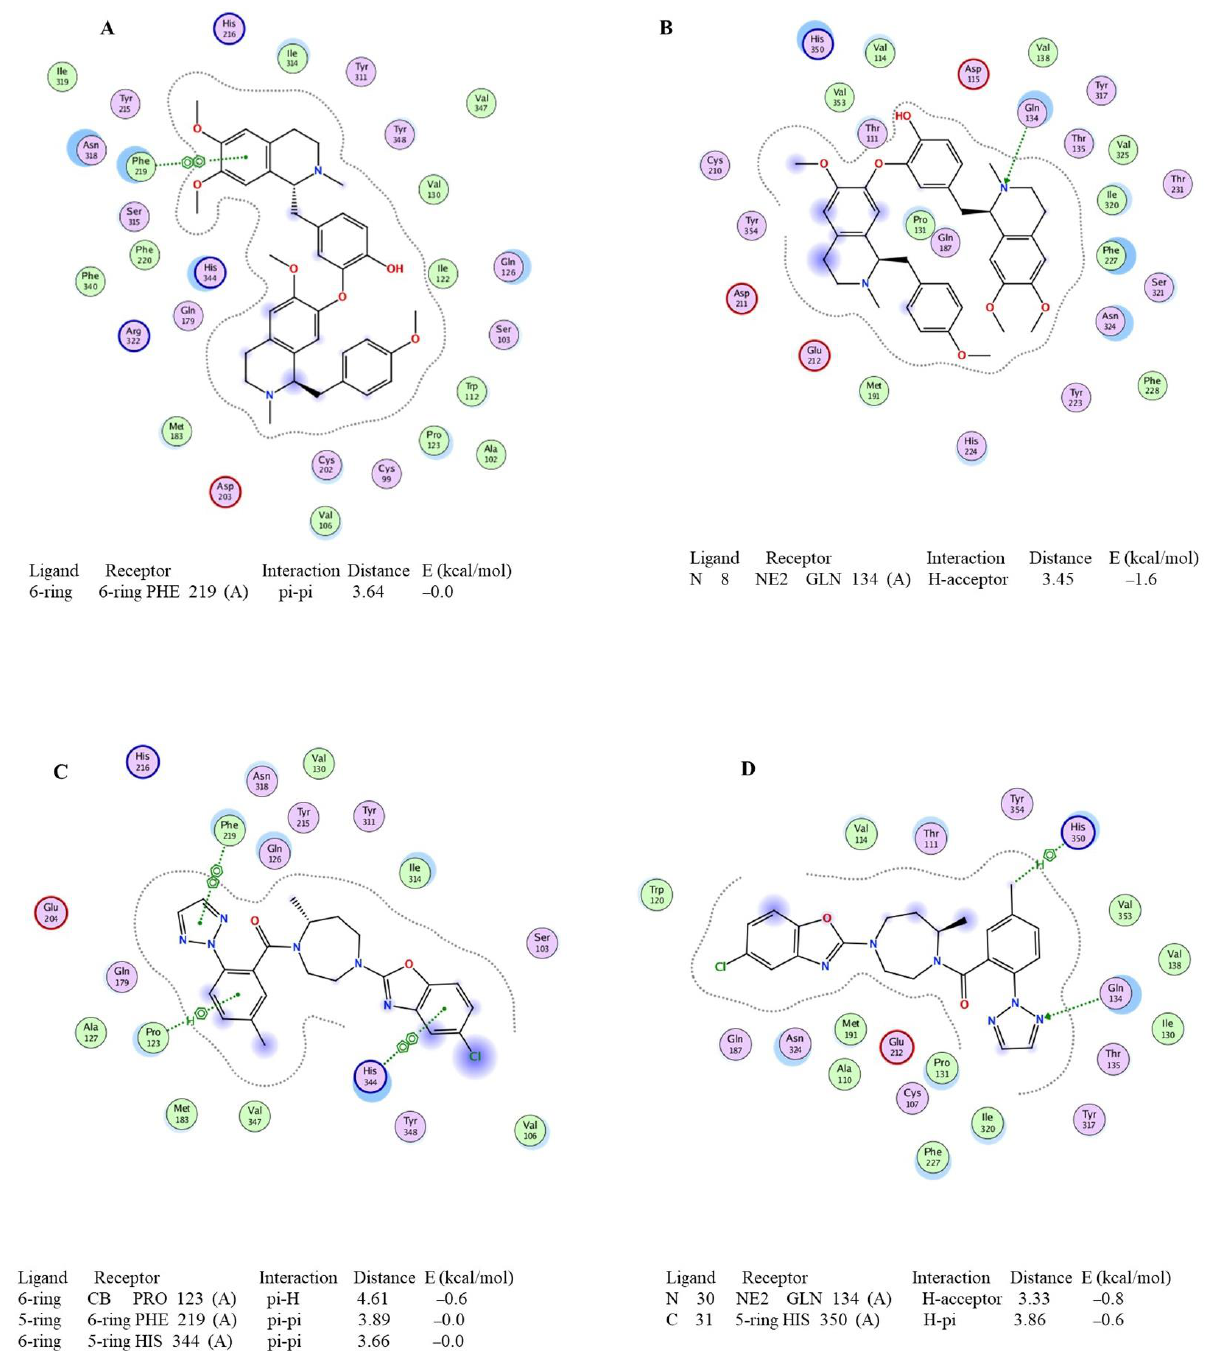
Figure 1. The molecular interactions between the orexin receptors and ligands (( A ): neferine and orexin 1 receptor; ( B ): neferine and orexin 2 receptor; ( C ): suvorexant and orexin 1 receptor; ( D ): suvorexant and orexin 2 receptor).